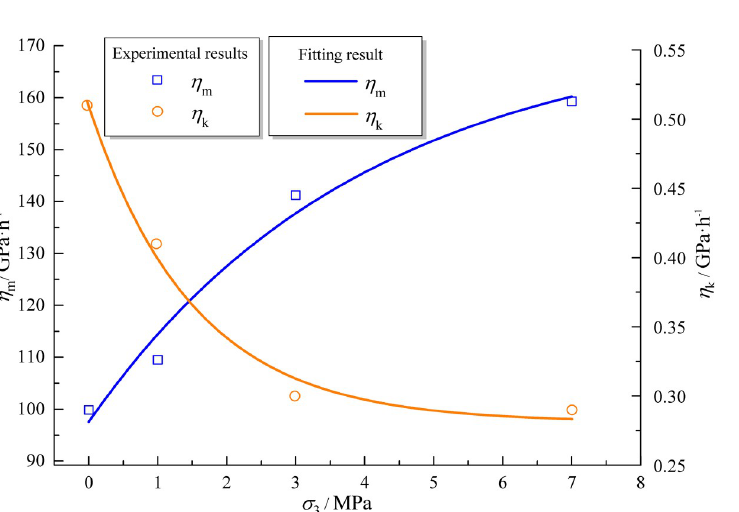
Fig 6. Viscosity coefficient of mudstone as a function of confining pressure.